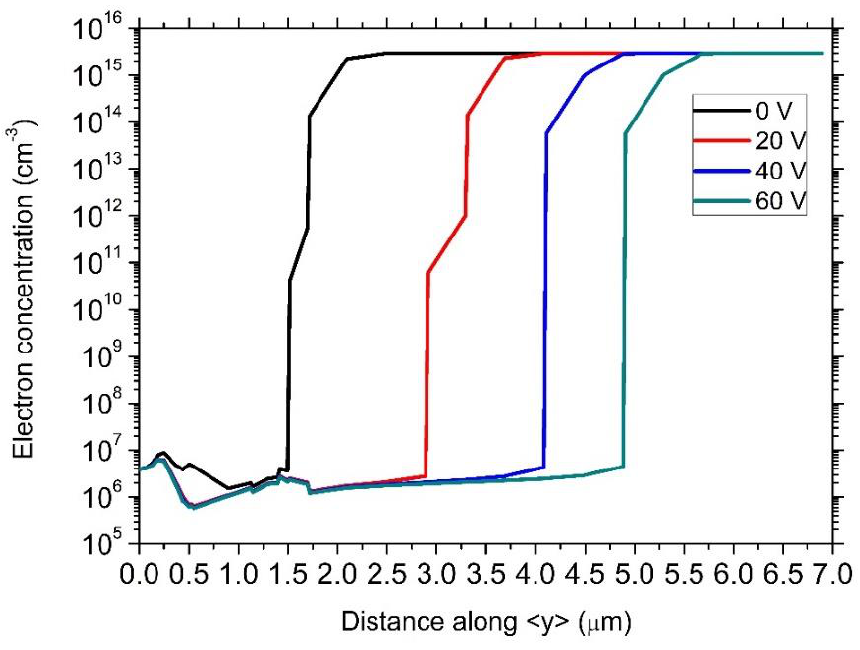
Figure 7. Electron concentration profile along the vertical <y> direction of the p − i − n photodiode at the responsivity peak wavelength from 0 V up to 60 V, in steps of 20 V.